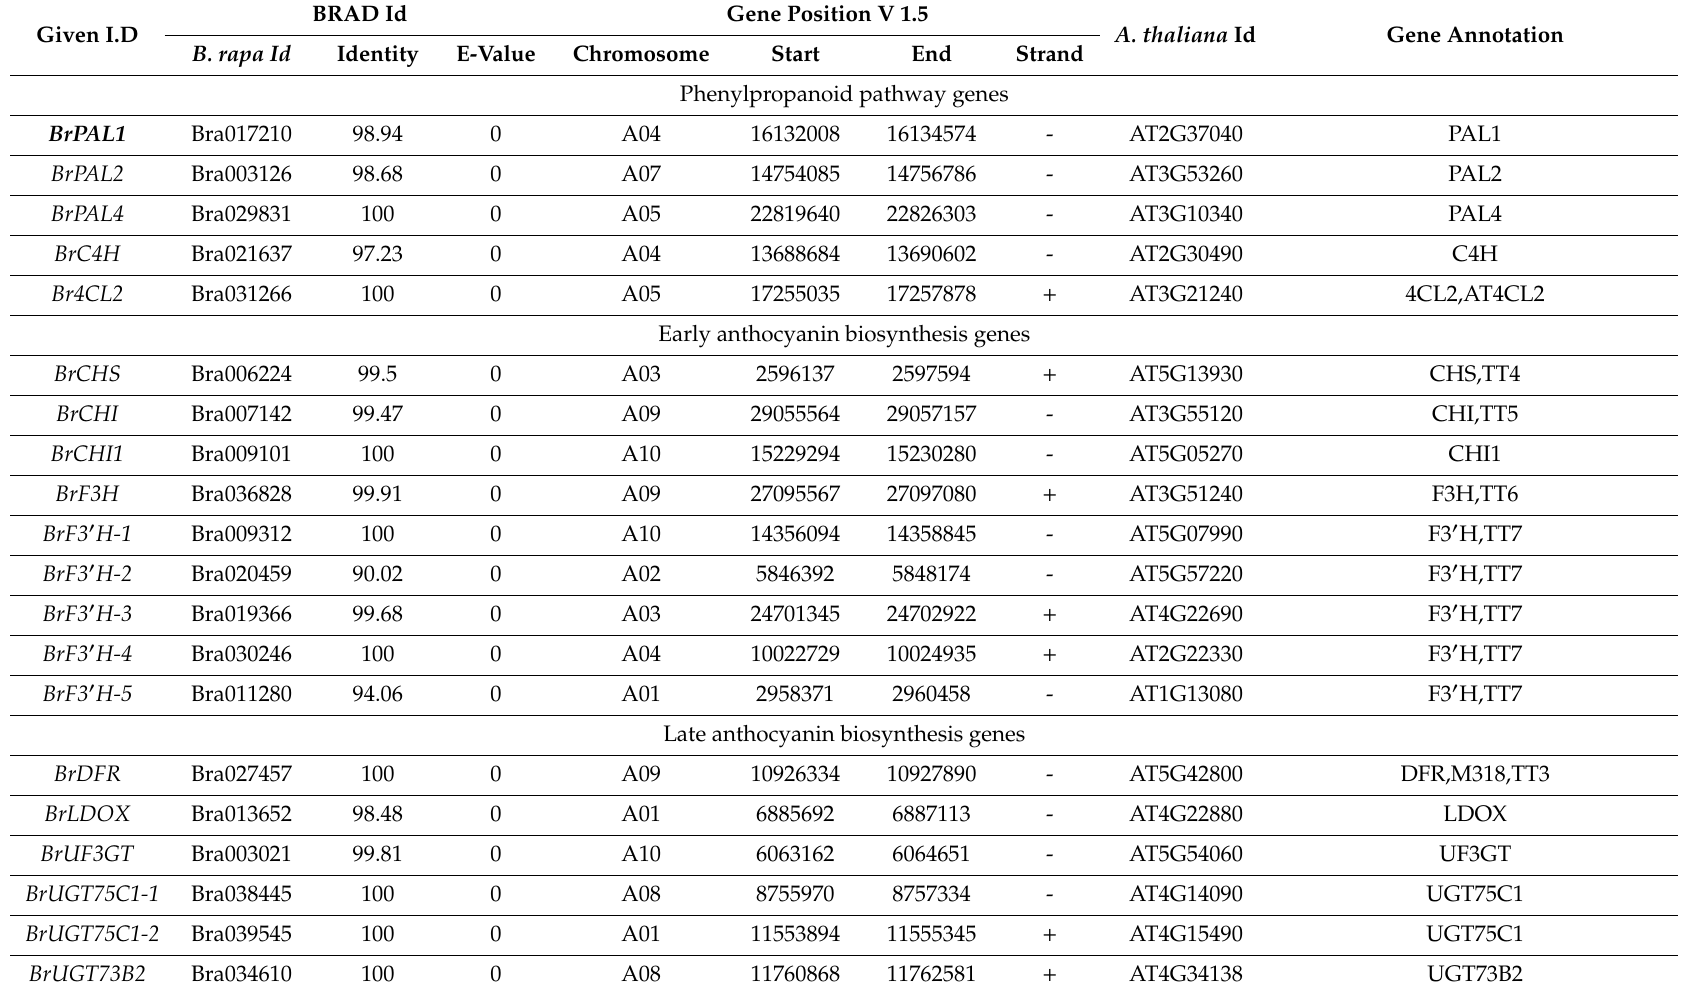
Table 4. Details of 60 genes selected for validation by qRT_PCR